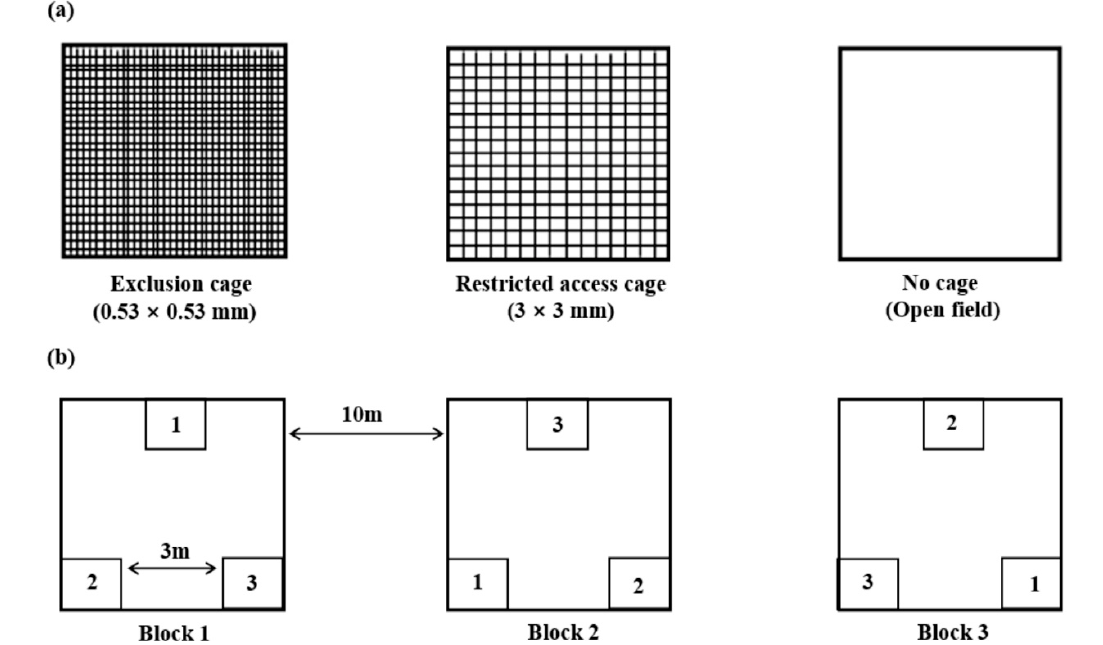
Figure 1. The device ( a ) and layout ( b ) of treatments in a field study in Ningxia Province, China, designed to assess the effects of the exclusion, restricted access, or full access of predators and parasitoids to the pea aphid, Acyrthosiphon pisum (cage design adapted from Han and Desneux 2014 [22]).